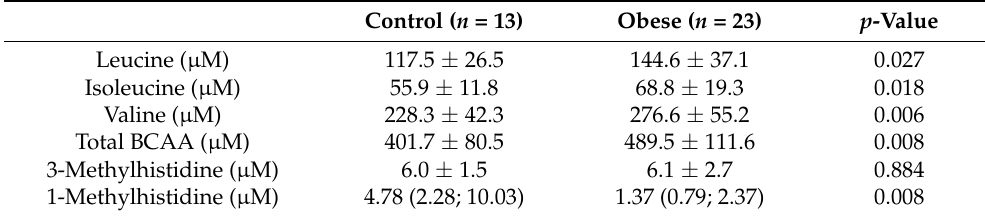
Table 4. Plasma amino acid concentrations by study